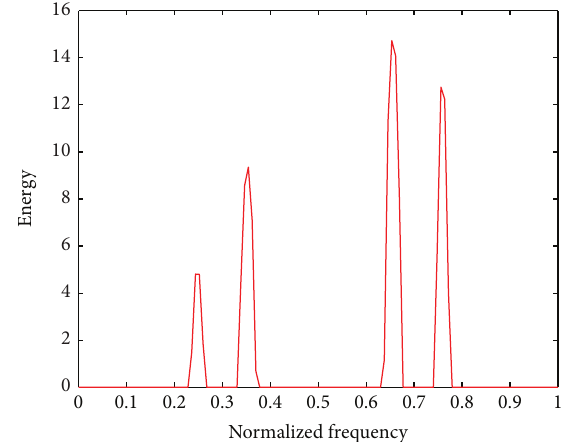
Figure 7: Complex constellation of constant modulus constrained